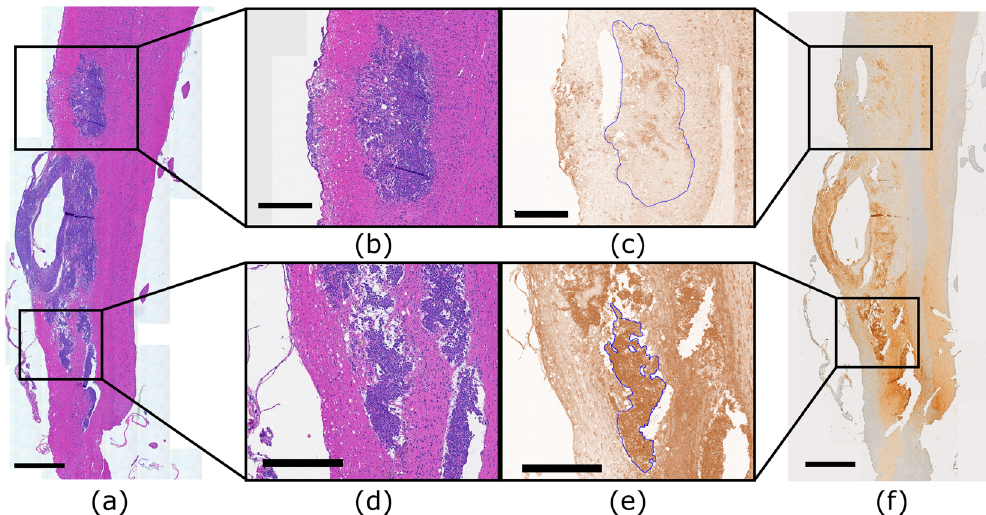
Figure 6. Spinal cord tissue of an LM rat prepared for histology showing tumor burden and trastuzumab distribution. ( a , b , d ) Stained with hematoxylin and eosin to view gross tumor morphology. ( c , e ) Stained with an anti-human IgG antibody to detect trastuzumab distributed throughout the tissue then deconvolved in ImageJ to visualize DAB signal. ( b , c ) Enlarged views of untargeted tumor tissue. ROI contoured in blue in slide c. ( d , e ) Enlarged views of targted tumor tissue. ROI contoured in blue in slide e. ( f ) Stained with an anti-human IgG antibody to detect trastuzumab distributed throughout the tissue. Scale bars: ( a , f ) 1 mm; ( b – e ) 0.5 mm.